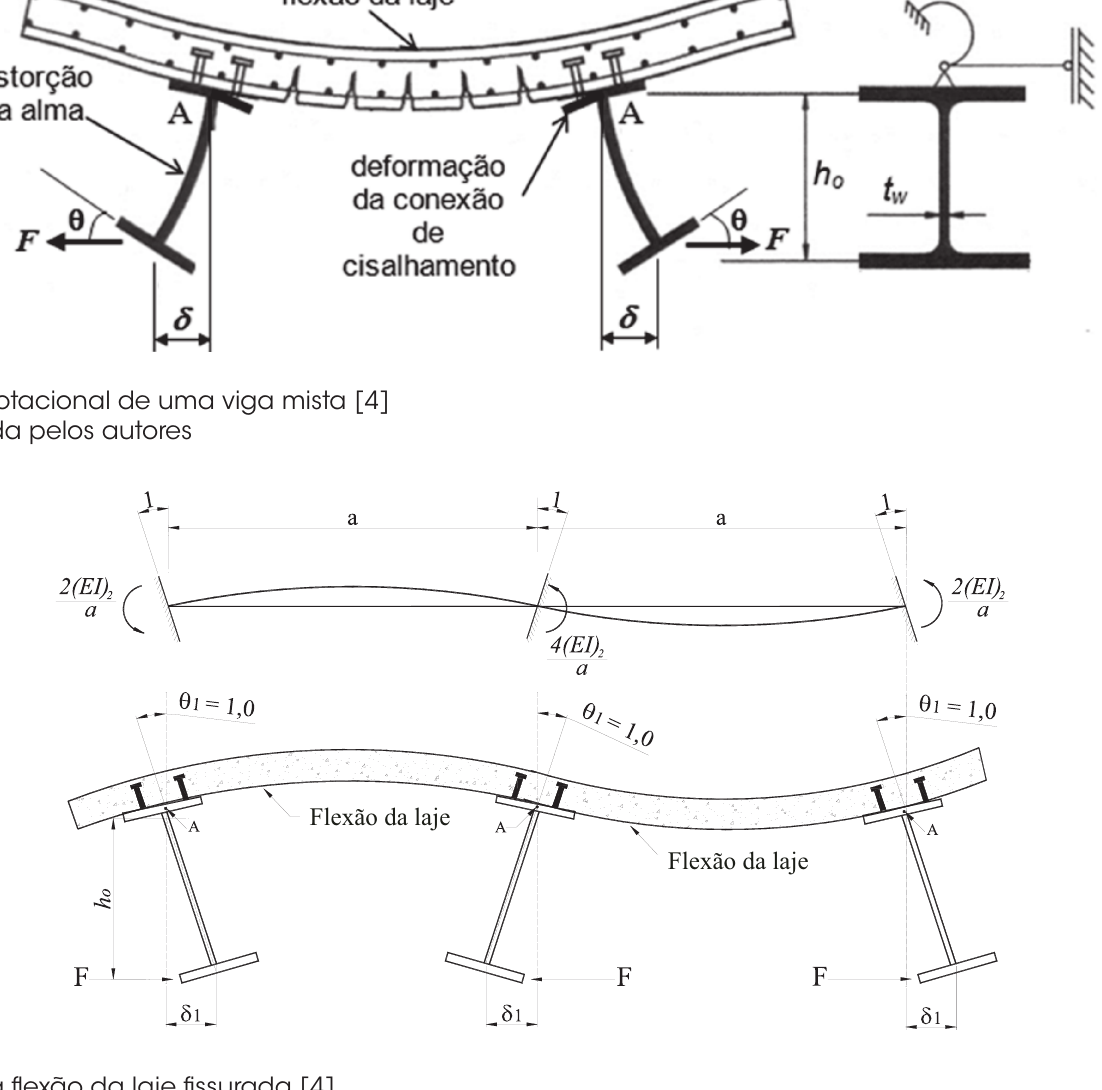
Rigidez à flexão da laje fissurada [4]